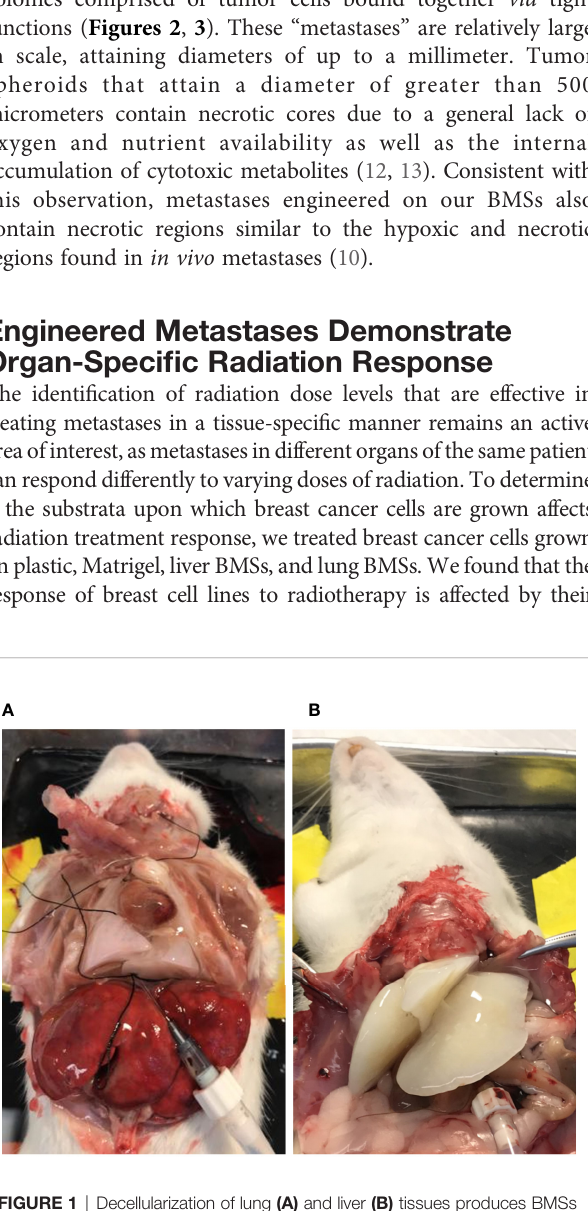
FIGURE 1 | Decellularization of lung (A) and liver (B) tissues produces BMSs containing tissue speci fi c signaling